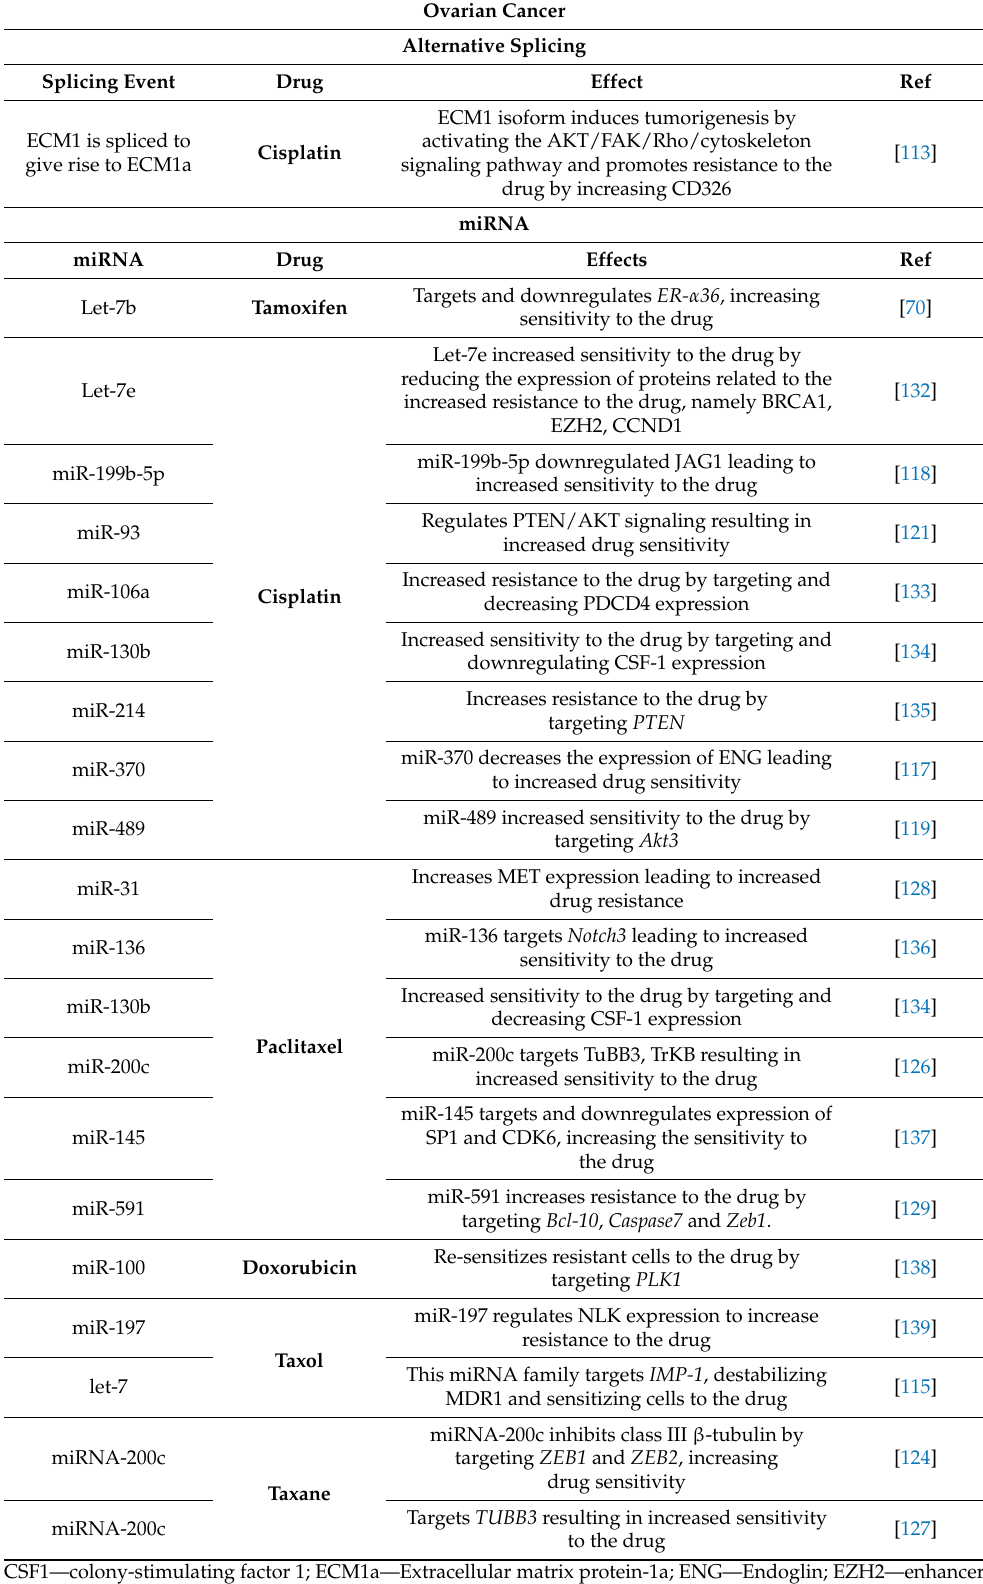
Table 4. Alternative splicing events and miRNAs involved in drug resistance in ovarian cancer